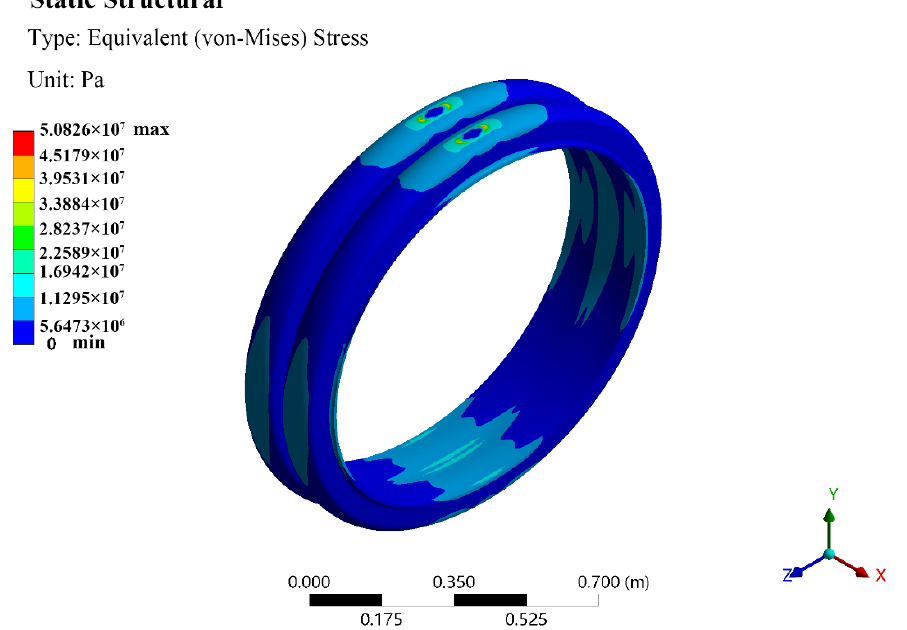
Figure 11. Equivalent stress distribution on a bellows. The diameter of the bellows is 1000 mm.